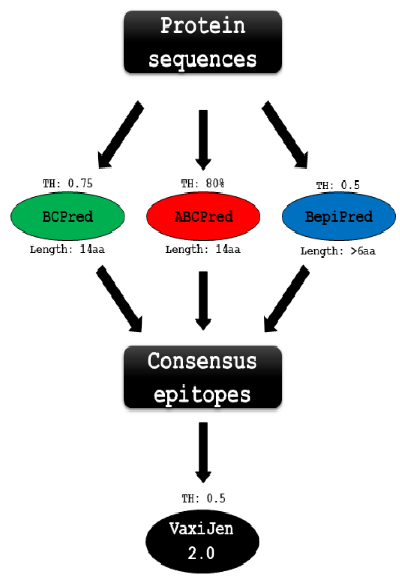
Figure 1. Flowchart of B-cell linear epitope prediction.